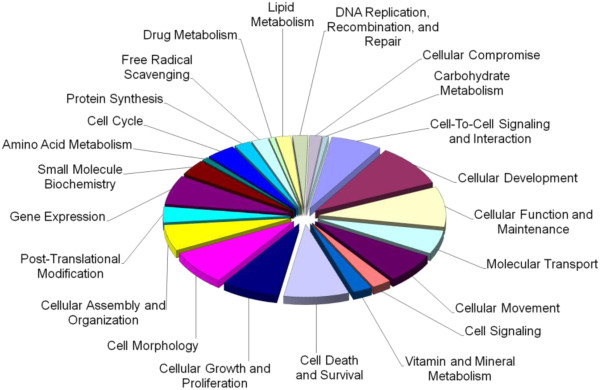
Molecular and cellular functions associated with mTOR-regulated genes differentially expressed in the frontal lobe of advanced AD patients. Molecular and cellular functions associated with genes differentially expressed in the frontal lobe of advanced AD patients (neocortical stage) compared to controls (176 genes). The chart shows the number of genes, expressed as a percentage of the total number, involved in each of the molecular and cellular functions deemed significant by IPA Ingenuity.